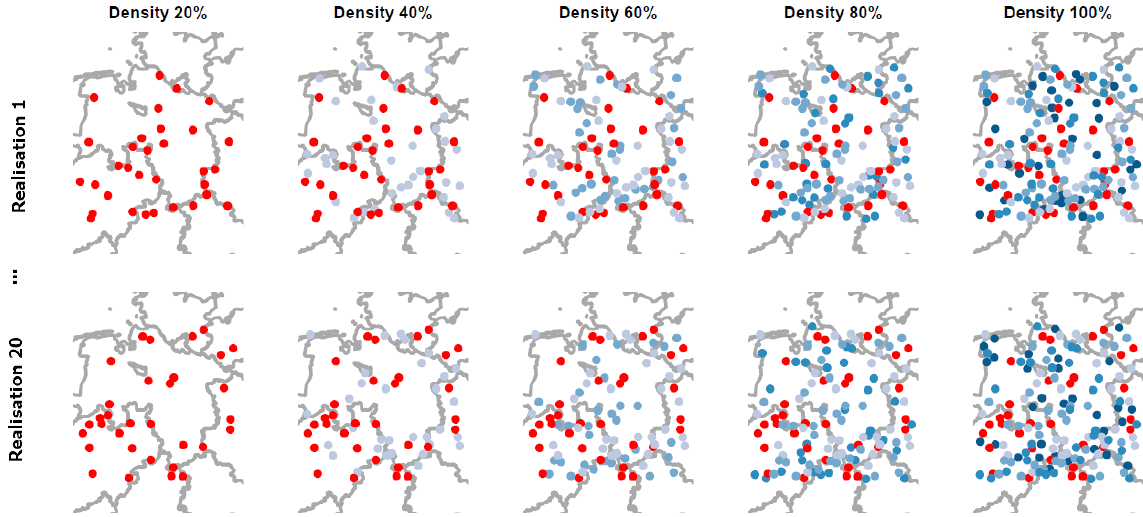
Figure 7. Five different station density scenarios shown for two realisations. The red stations are used for the cross validation for all station densities. The additional stations (blue) provide supplementary information for the regionalisation, with darker shades added to previous